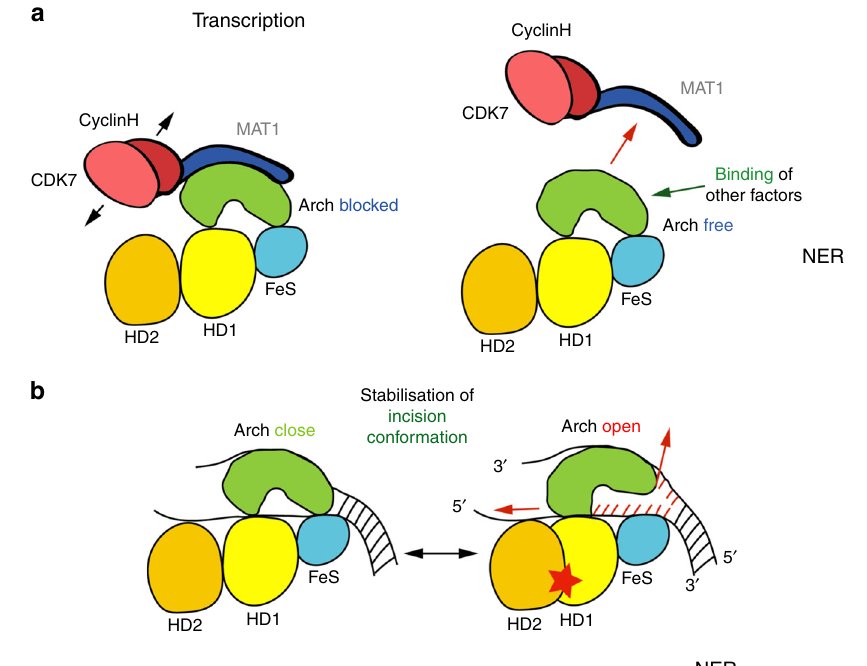
Fig. 6 Involvement of the Arch domain in the helicase mechanism. a Schematic representation of XPD and CAK in transcription and NER. b Cartoon representation of the suggested Arch domain dynamics related to ATP hydrolysis thereby aiding in strand